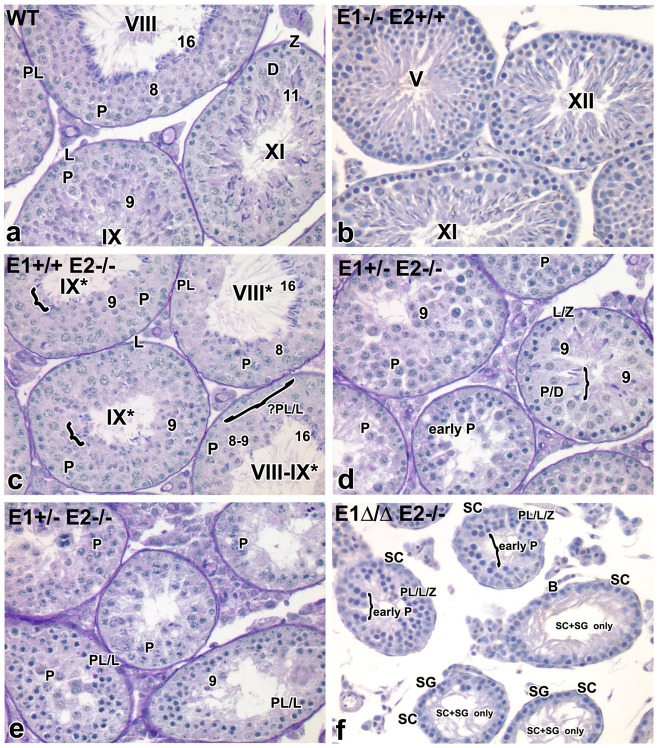
Additional E-type cyclin deficiency causes progressive loss of advanced spermatogenic cells.(a–f) Histological sections of representative seminiferous tubules in E1−/−E2+/+, E1+/+E2−/−, E1+/−E2−/− and E1Δ/ΔE2−/− testes counter-stained with PAS-hematoxylin. Magnification: a–f ×40. SC, Sertoli cells; PL/L, preleptotene-leptotene spermatocytes; Z, zygotene spermatocytes; D, diplotene spermatocytes; P, pachytene spermatocytes; RS, round spermatids. The missing layer of specific cell types (Figure 3c) is indicated with a bracket and question mark. Arabic numerals indicate step of spermatid differentiation; Roman numerals indicate stage of the tubules. Although abnormal cell associations complicate staging, an attempt was made using the acrosomal system [45], and tubules are labeled with a Roman numeral followed by an asterisk (e.g. stage IX*).